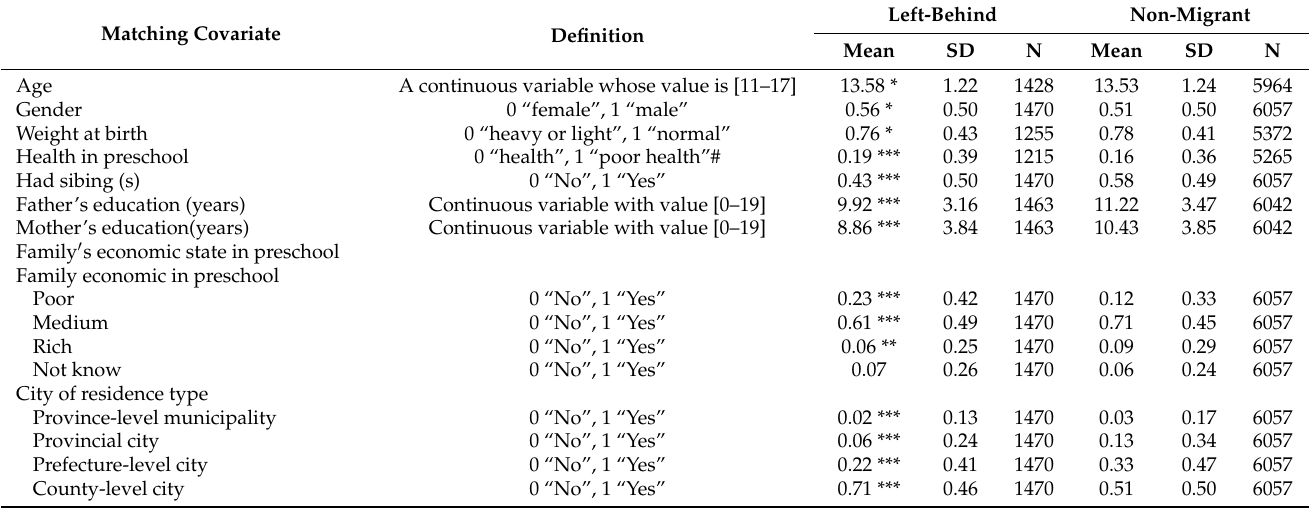
Table 3. Definitions and descriptive statistics of the matching variables in the analytical sample of urban children (N = 7527): CEPS